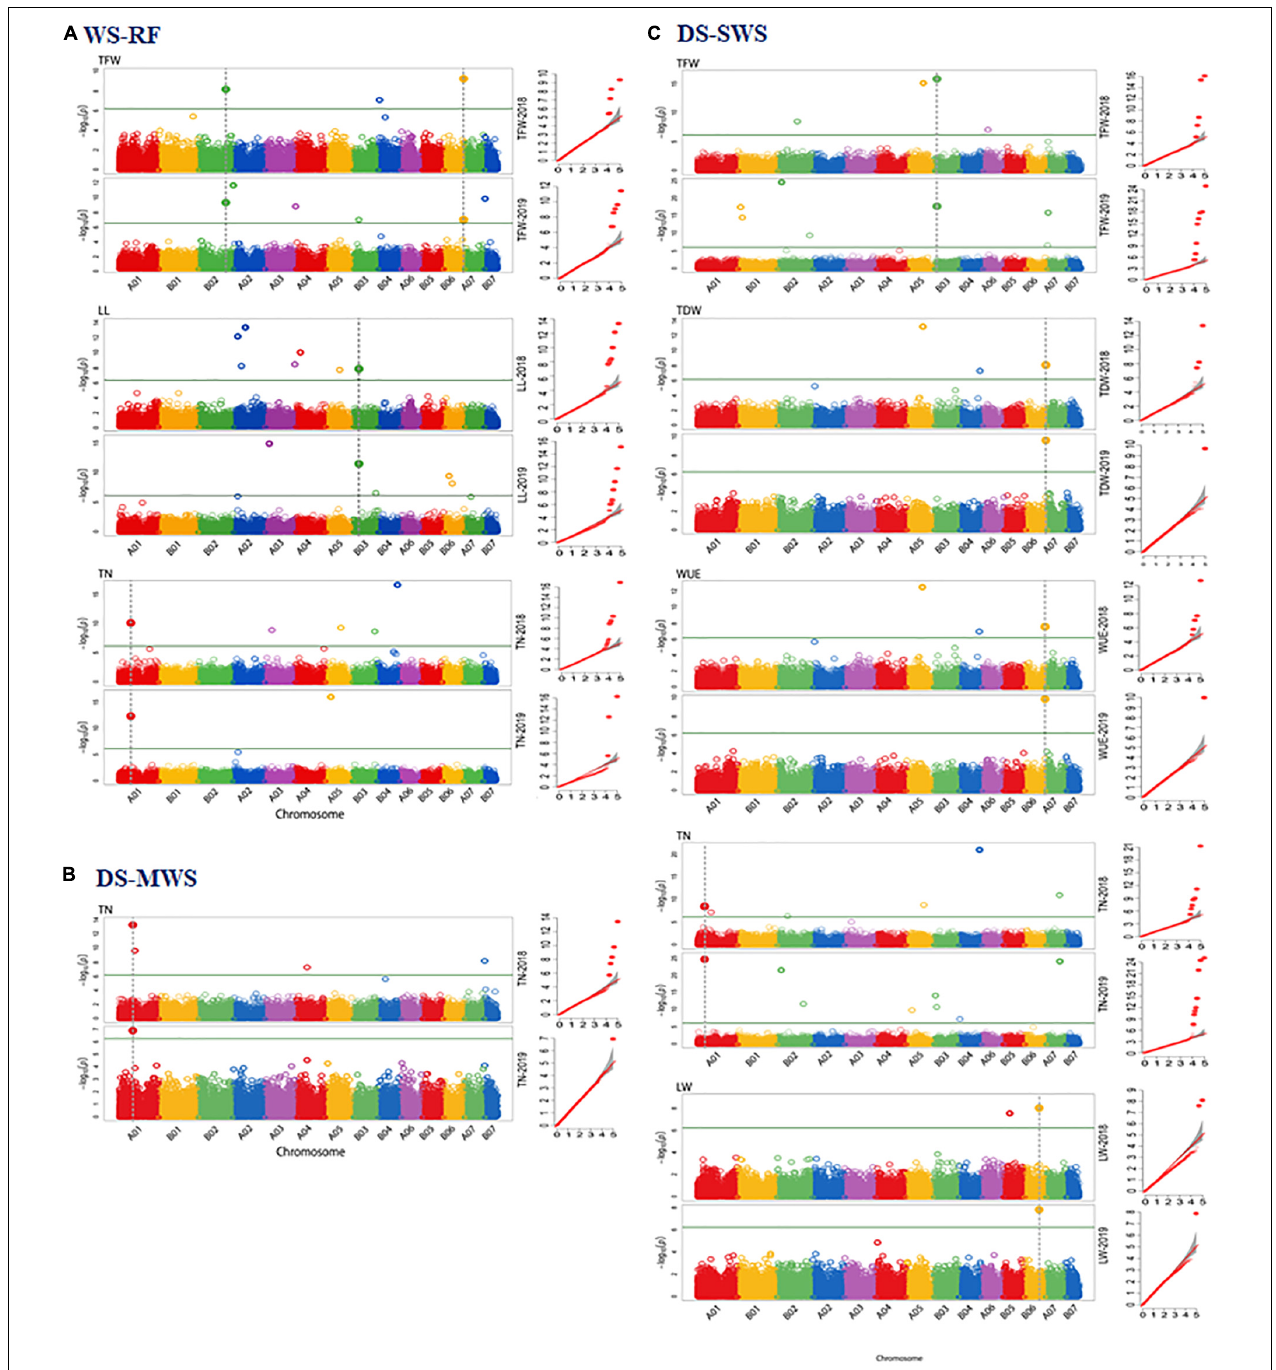
FIGURE 4 | Manhattan and quantile-quantile (Q-Q) plots of markers that showed overlapping associations in 2 years data of the agronomic and morphological traits in wet season under rainfed (WS-RF) (A) , dry season under moderate water stress (DS-MWS) (B) , and dry season under severe water stress (DS-SWS) (C) conditions. Markers are on the x -axis per the 14-assembled chromosomes (AC). The –log10 of P values are plotted on the y -axis. The traits are shown at the left, total fresh weight (TFW), total dry weight (TDW), water-use efficiency (WUE), leaf length (LL), leaf width (LW), and tiller number (TN).